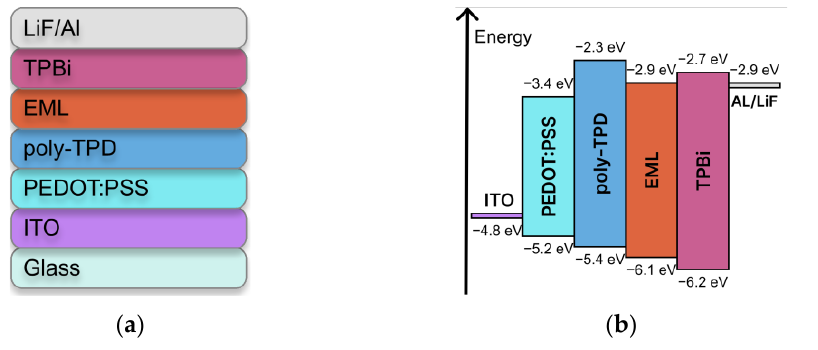
Figure 4. ( a ) Heterostructure and ( b ) band structure of OLEDs.